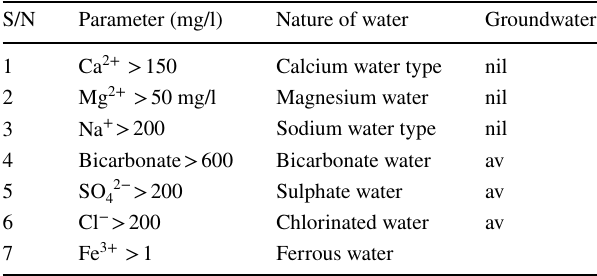
Table 2 Classification of groundwater samples based on the predomi-